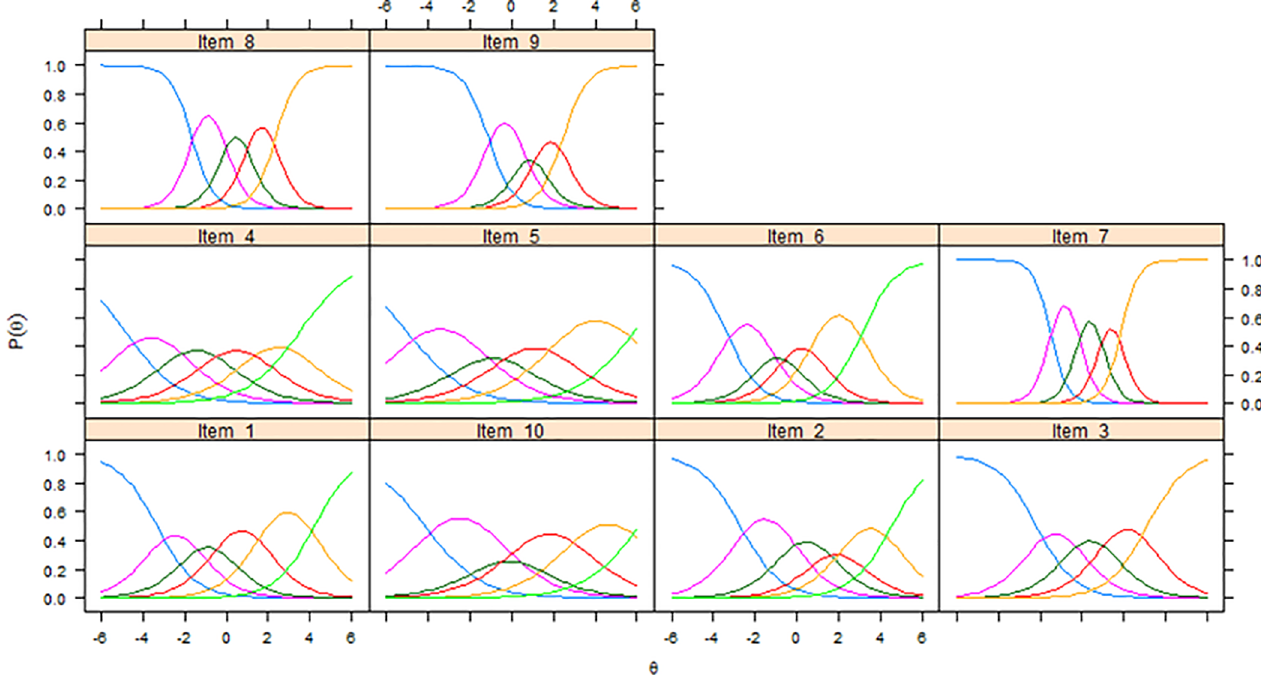
Fig 1. Item characteristic curves of the 10 items of the biomedical scale of the Pain Attitudes and Beliefs Scale (PABS) in the BeBack study.